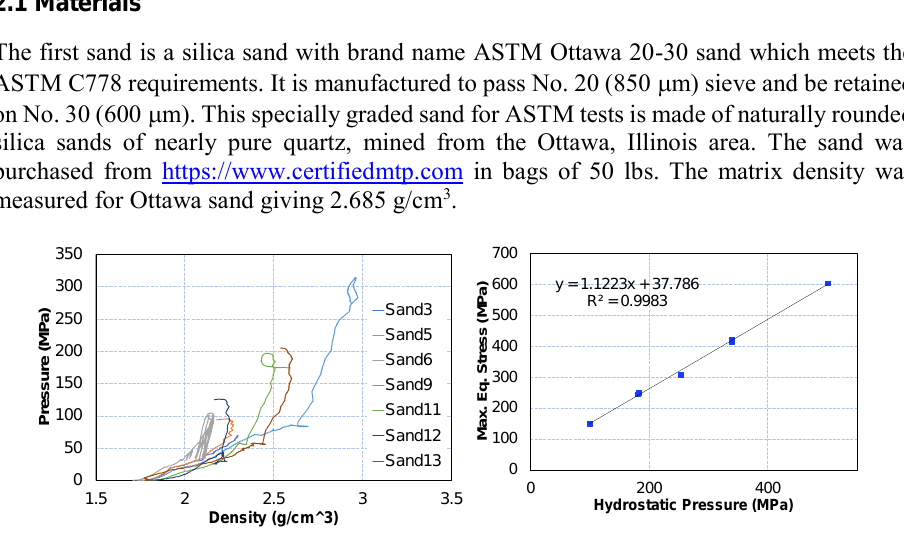
Figure 1 . Ottawa Sand a) Compaction curves, b) Strength vs.